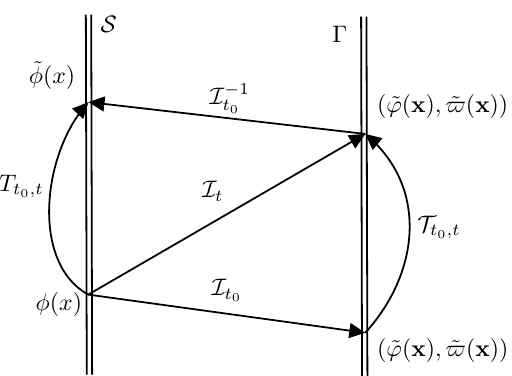
Figure 1 . Diagram representing the isomorphic relation between the covariant phase space the canonical phase space (cid:0). The evolution operator understood as the initial conditions for a certain solution (cid:30) (cid:0) provides a one-parameter family of complex structures J t = t : (cid:0) J !